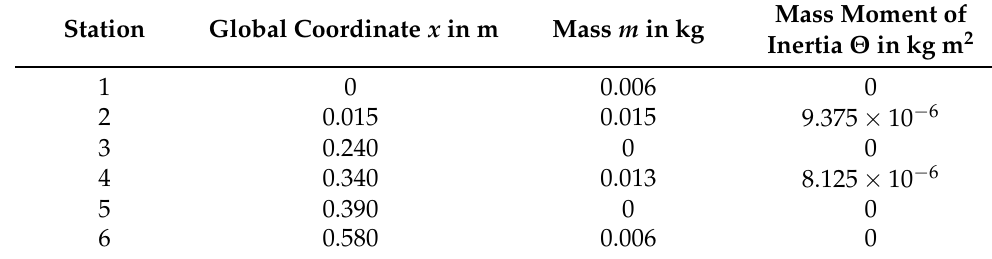
Table 2. List of the additional components of the numerical example.